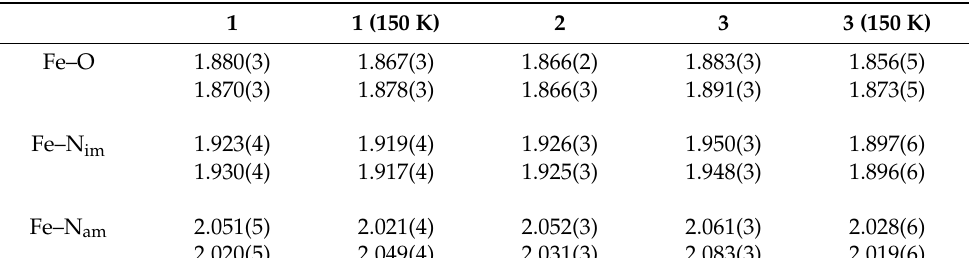
Table 2. Selected bond lengths at room-temperature [Å] for complexes 1 , 2 , and 3 and at 150 K for complexes 1 and 3 .